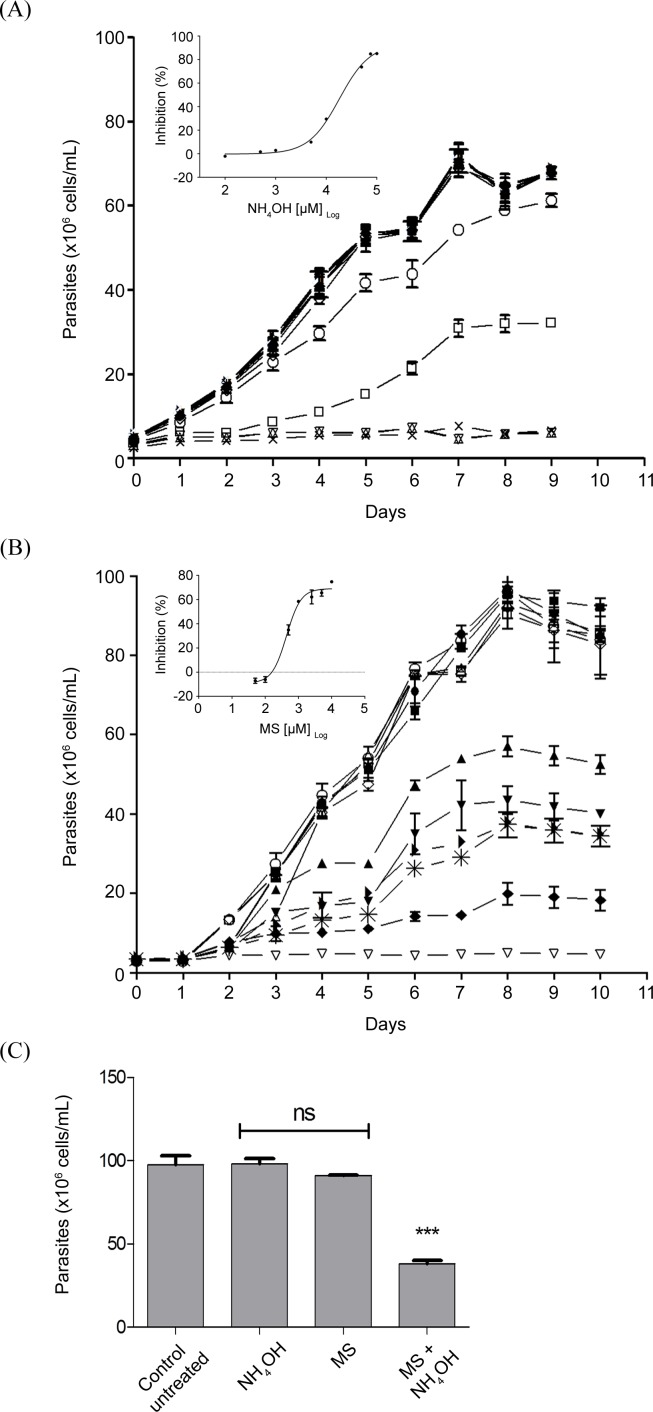
Effect of extracellular NH4+, MS and their combination on E proliferation.(A) The effect of different concentrations of NH4+ on E replication was evaluated by culturing them in liver infusion tryptose (LIT) medium at 28°C supplemented with different concentrations of NH4OH (in all cases, the pH was adjusted to 7.4). Parasites were quantified daily as previously described [46]. Symbols: filled circles: 1 μM; filled squares: 5 μM; right-side up filled triangles: 10 μM; upside-down filled triangles: 50 μM; right-side up filled triangles: 100 μM; left filled triangles: 500 μM; filled diamonds: 1 mM; open diamonds: 5 mM; open circles: 10 mM; open squares: 50 mM; right-side up open triangles: 75 mM; right open triangles: 100 mM; asterisks: untreated (control); x symbol: 0.5 μM antimycin and 60 μM rotenone (100% growth inhibition control). Inset: dose-response curve (EC50 = 17.77 ± 0.99 mM). (B) The effect of different concentrations of MS and 5 mM NH4OH on E replication was evaluated by culturing them in LIT medium at 28°C. Parasites were quantified daily. Symbols: filled circles: 0.05 mM; filled squares: 0.1 mM; right-side up filled triangles: 0.5 mM; upside-down filled triangles: 1 mM; right filled triangles: 2.5 mM; asterisks: 5 mM; filled diamond: 10 mM; open diamonds: 5 mM MS without NH4OH; open circles: 10 mM MS without NH4OH; open squares: control (no treatment); right-side up open triangles: 5 mM NH4OH without MS; upside-down open triangles: 0.5 μM antimycin and 60 μM rotenone (100% growth inhibition control). Inset: dose-response curve for MS in the presence of NH4OH (EC50 = 438.4 ± 47.4 μM). (C) The combined effect of 1 mM MS and 5 mM NH4OH on epimastigote proliferation measured at the mid-exponential phase of untreated cultures (4th day of proliferation). Statistical analysis were made using one-way ANOVA / Dunnet’a Multiple Comparision Test. *p<0.05, **p<0.01, ***p<0.001. Error bars represent standard deviation (n = 3).